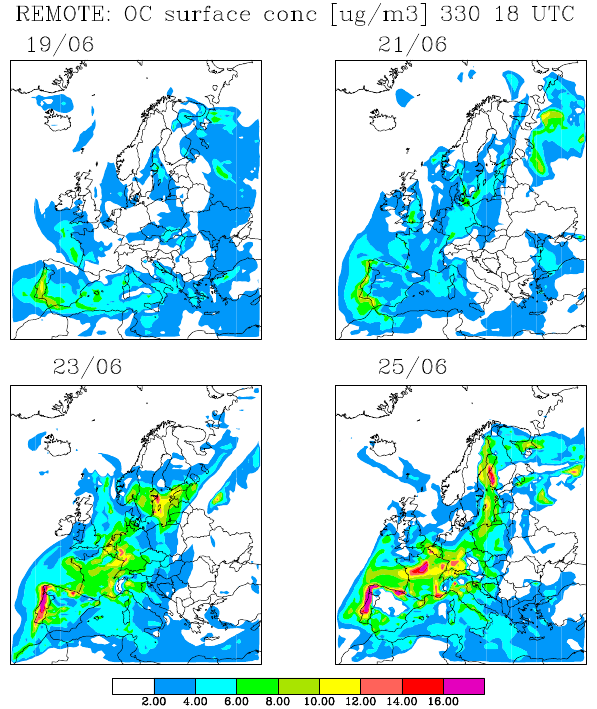
Fig. 5. Modelled near-surface concentration of organic carbon aerosol in µgm − 3 on 19, 21, 23 and 25 June at 18:00UTC by con- sidering the second aging of SOG and a threshold of 10% for aging. Model simulation results correspond to those shown by the light blue line in Fig.